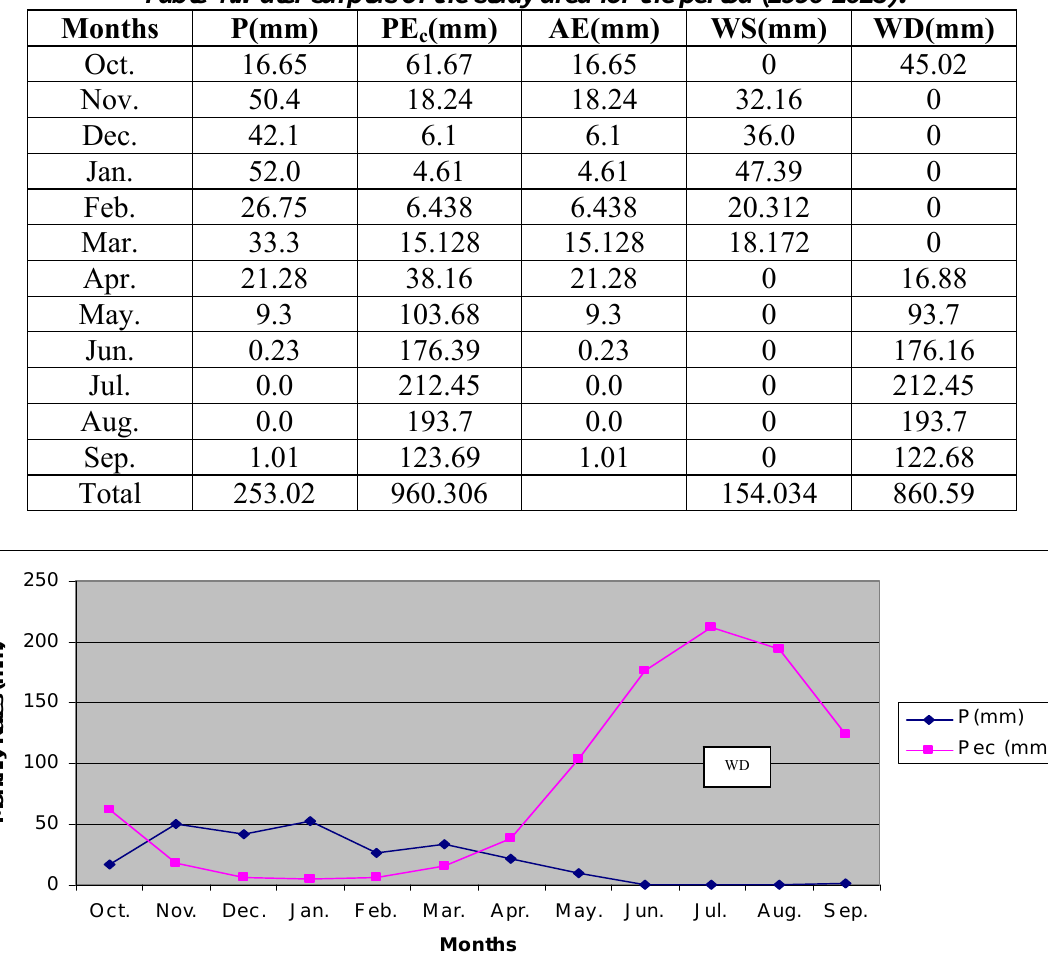
Table 4:Water surplus of the study area for the period (1990-2013).